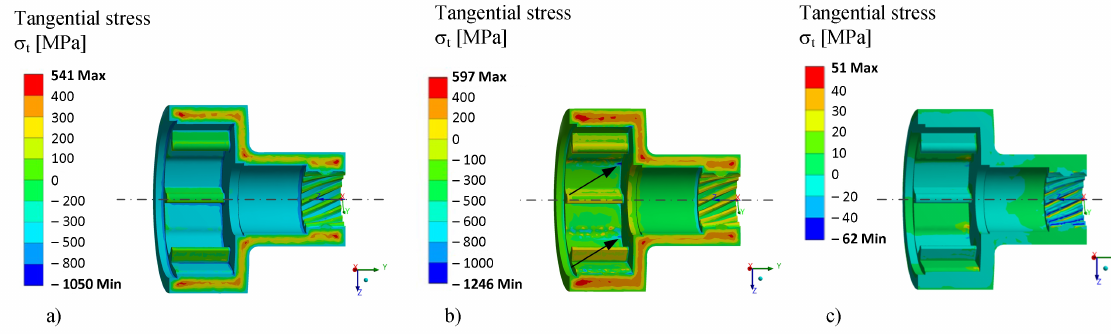
Figure 7. Tangential stresses in the starter clutch barrel ( a ) after the heat treatment, ( b ) at the time of operation and ( c ) without the consideration of heat treatment at the time of